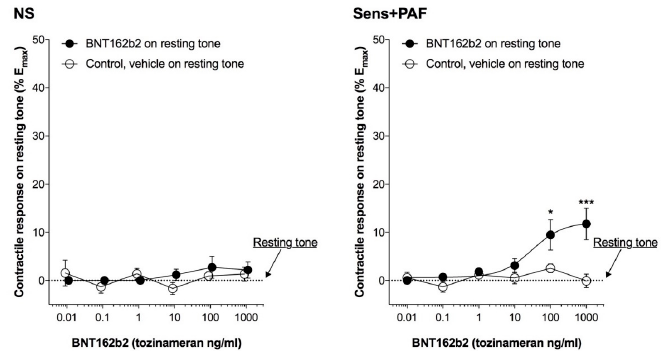
Figure 1. Effect of BNT162b2 on isolated airways resting tone in NS and sens+PAF isolated airways. * p < 0.05 and *** p < 0.001 vs. control; results reported as mean ± SE of n = 5 human isolated sub- segmental bronchi. NS: non-sensitized; PAF: platelet-activating factor; SE: standard error; sens+PAF: passively sensitized plus PAF challenge.